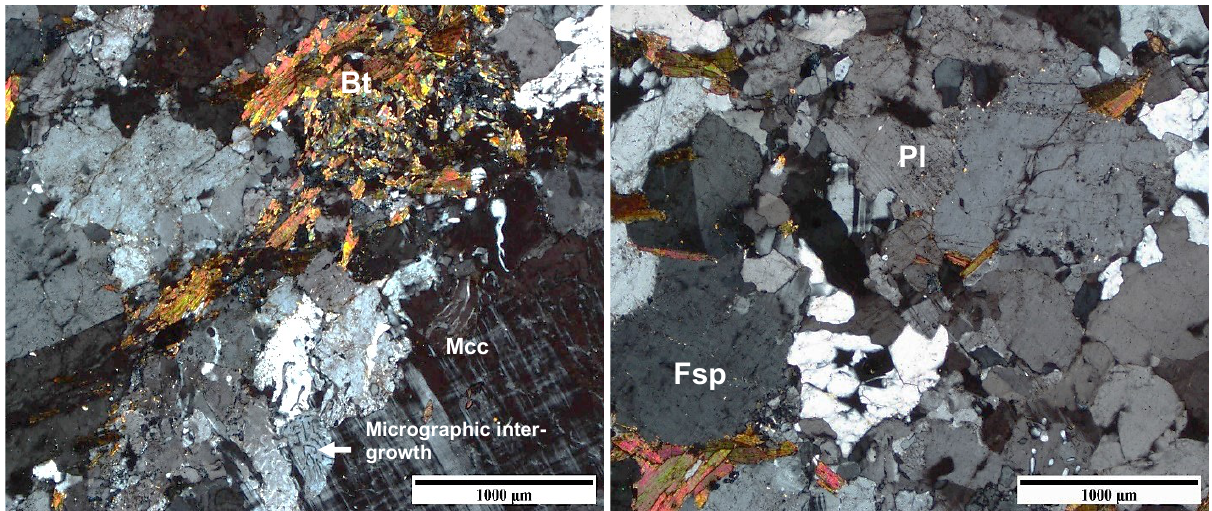
Fig. 9. Microphotograph of third phase biotite granite, Khangai Complex (Si-396), Bt-biotite, Pl-plagioclase